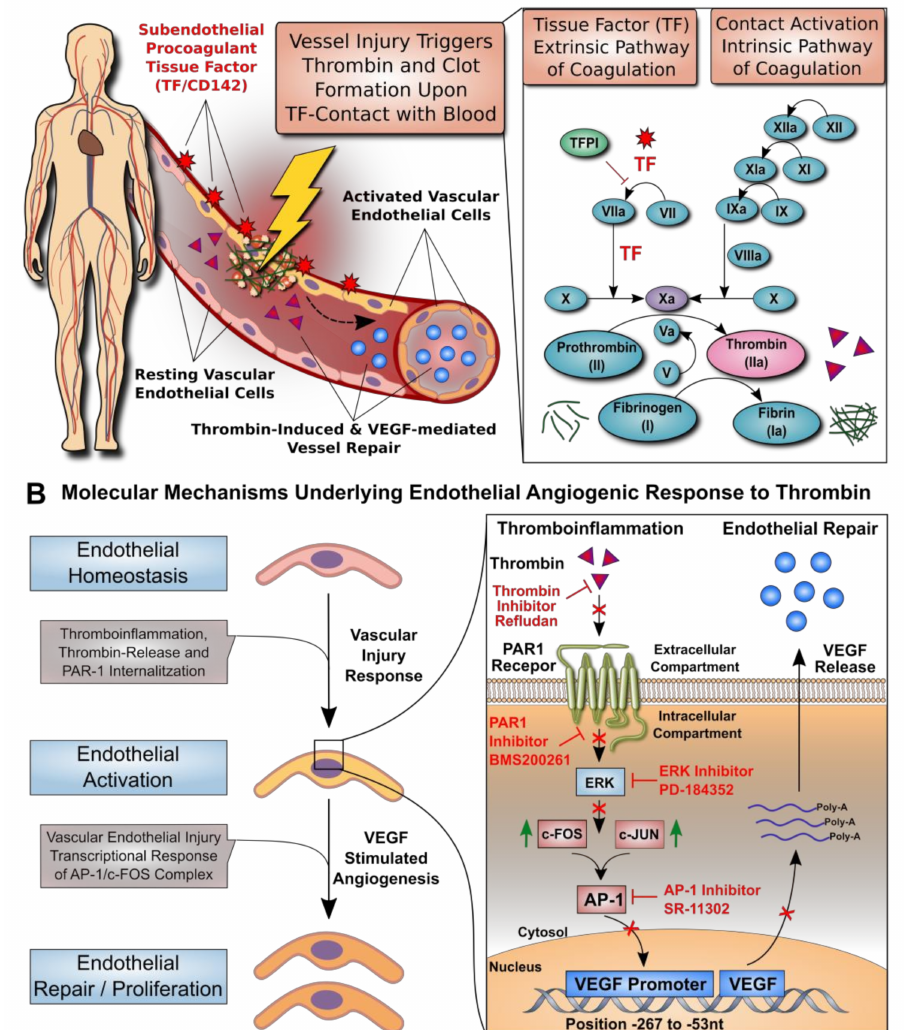
Figure 1. Transcriptional regulation of thrombin-induced endothelial cell VEGF induction. ( A ) Vessel injury and